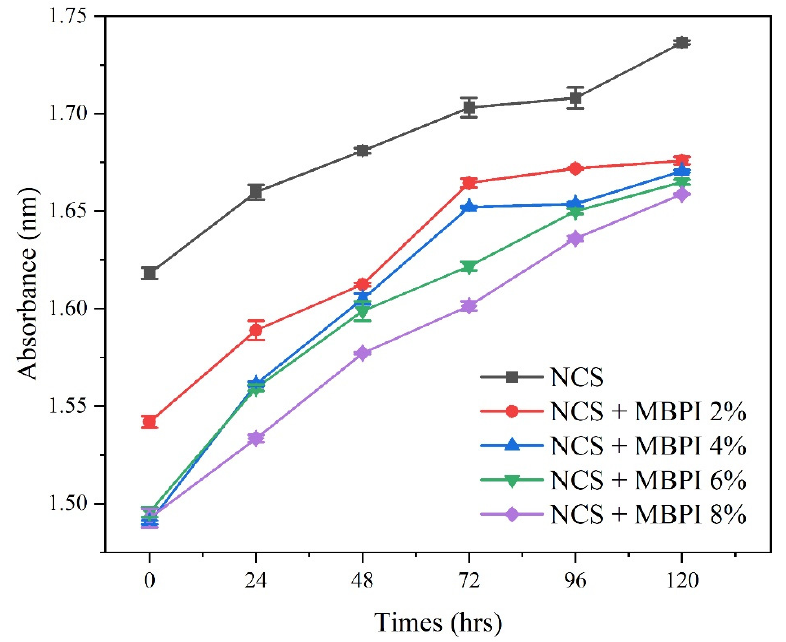
Figure 4. The turbidity of NCS and NCS/MBPI gels at different MBPI concentrates (2%, 4%, 6%, and 8%) during 120 h storage at 4 °C.